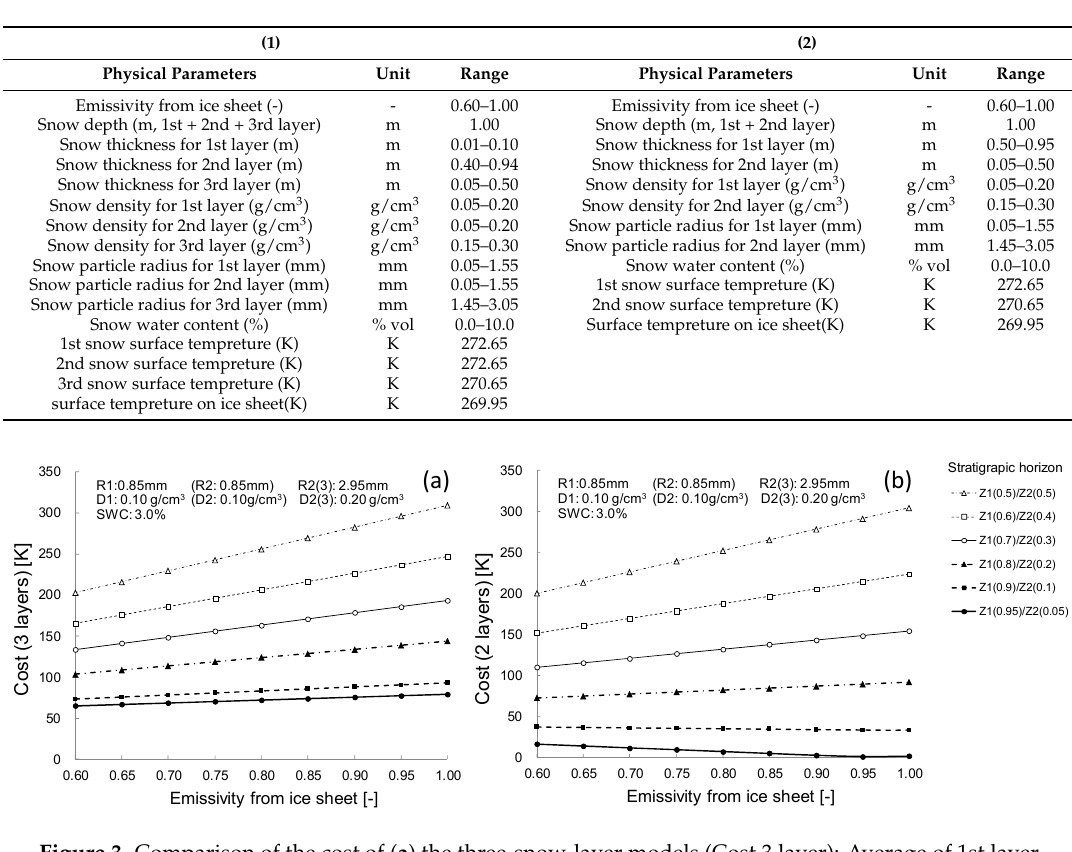
Table 2. Range in physical parameters explored to determine the optimum physical parameters in the microwave region for (1) the three-snow-layer model, and (2) the two-snow-layer model.